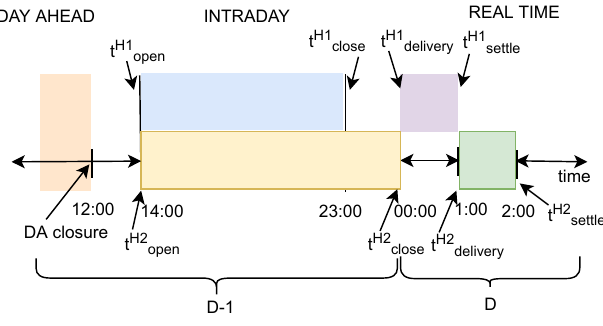
Figure 1. Graphical representation of the limit order book at time t